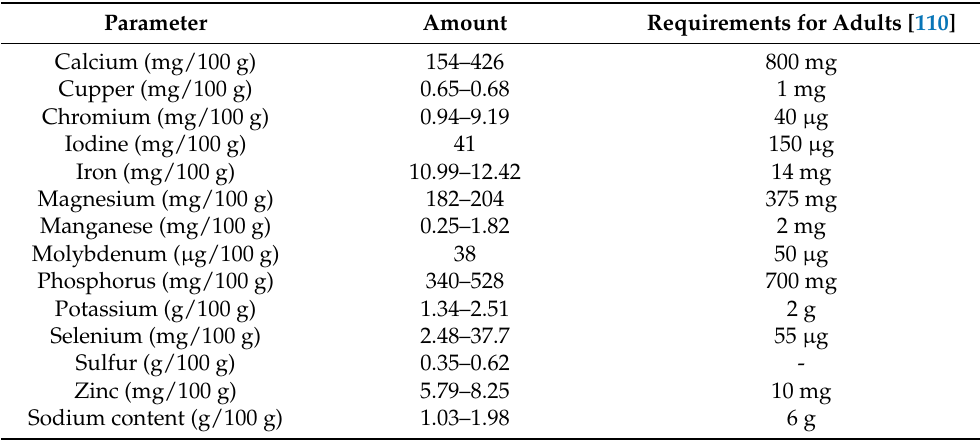
Table 4. Trace mineral content in Yarrowia lipolytica protein powder (dry weight).